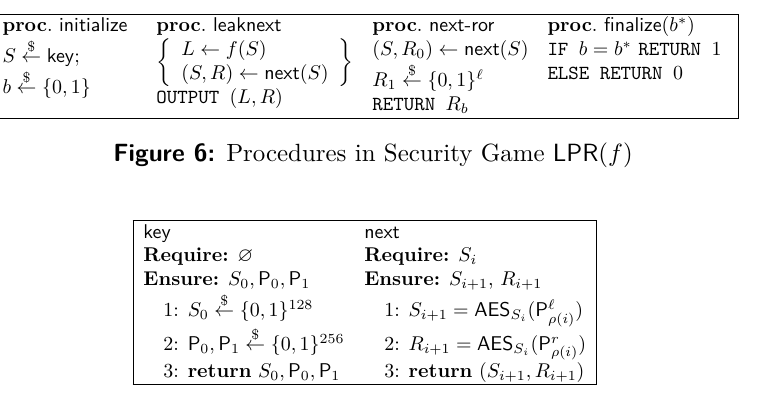
Figure 7: LPR ( f ): Construction from [YSPY10]